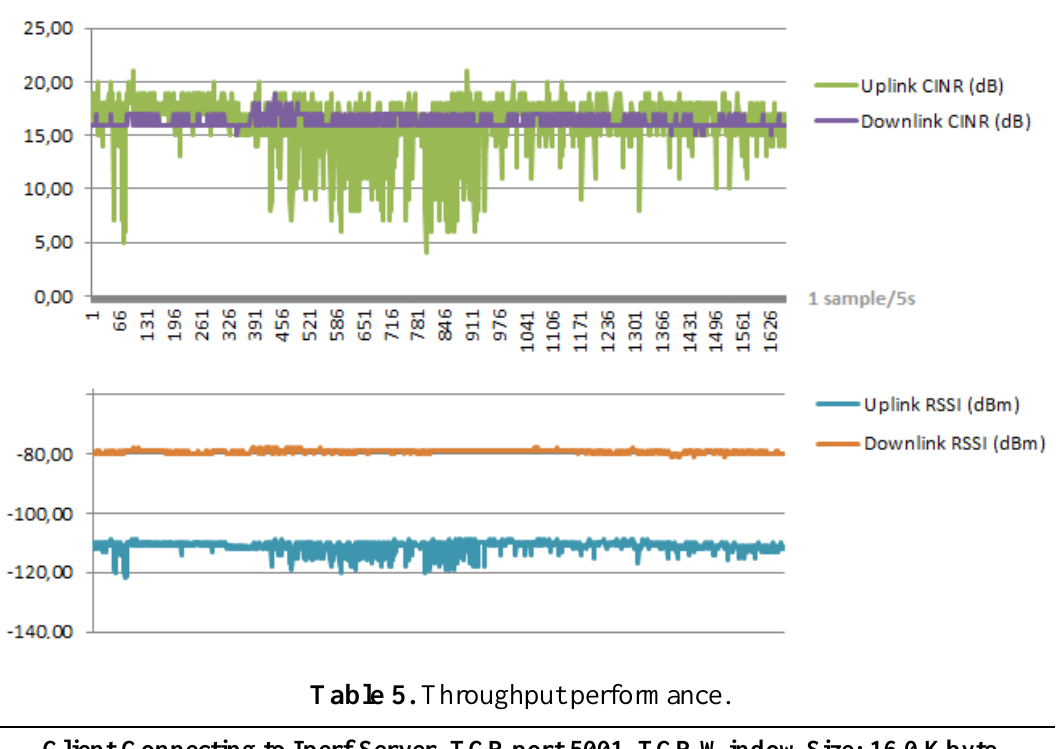
Figure 7. Monitoring of the radio parameters.